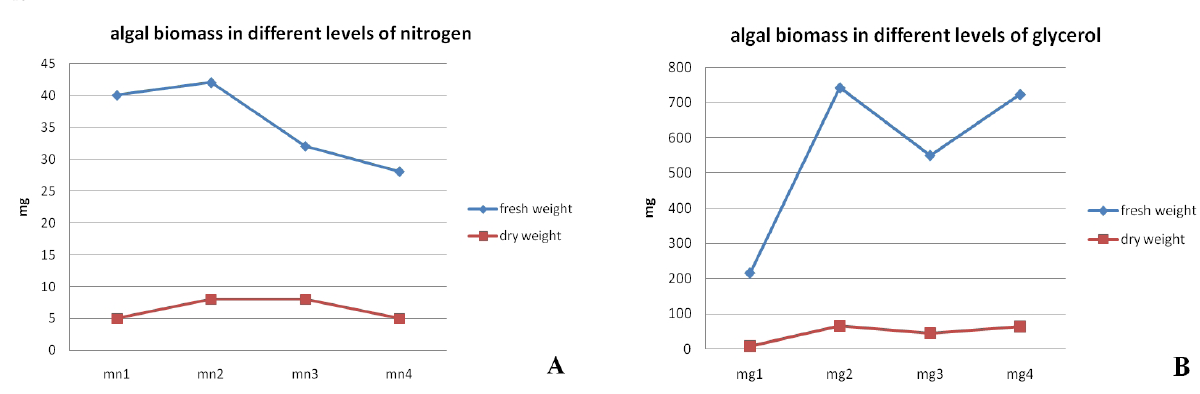
Fig. 7. FW and DW of S. dimorphus in Modified Bold 3N medium with different levels of nitrogen (A) and glycerol